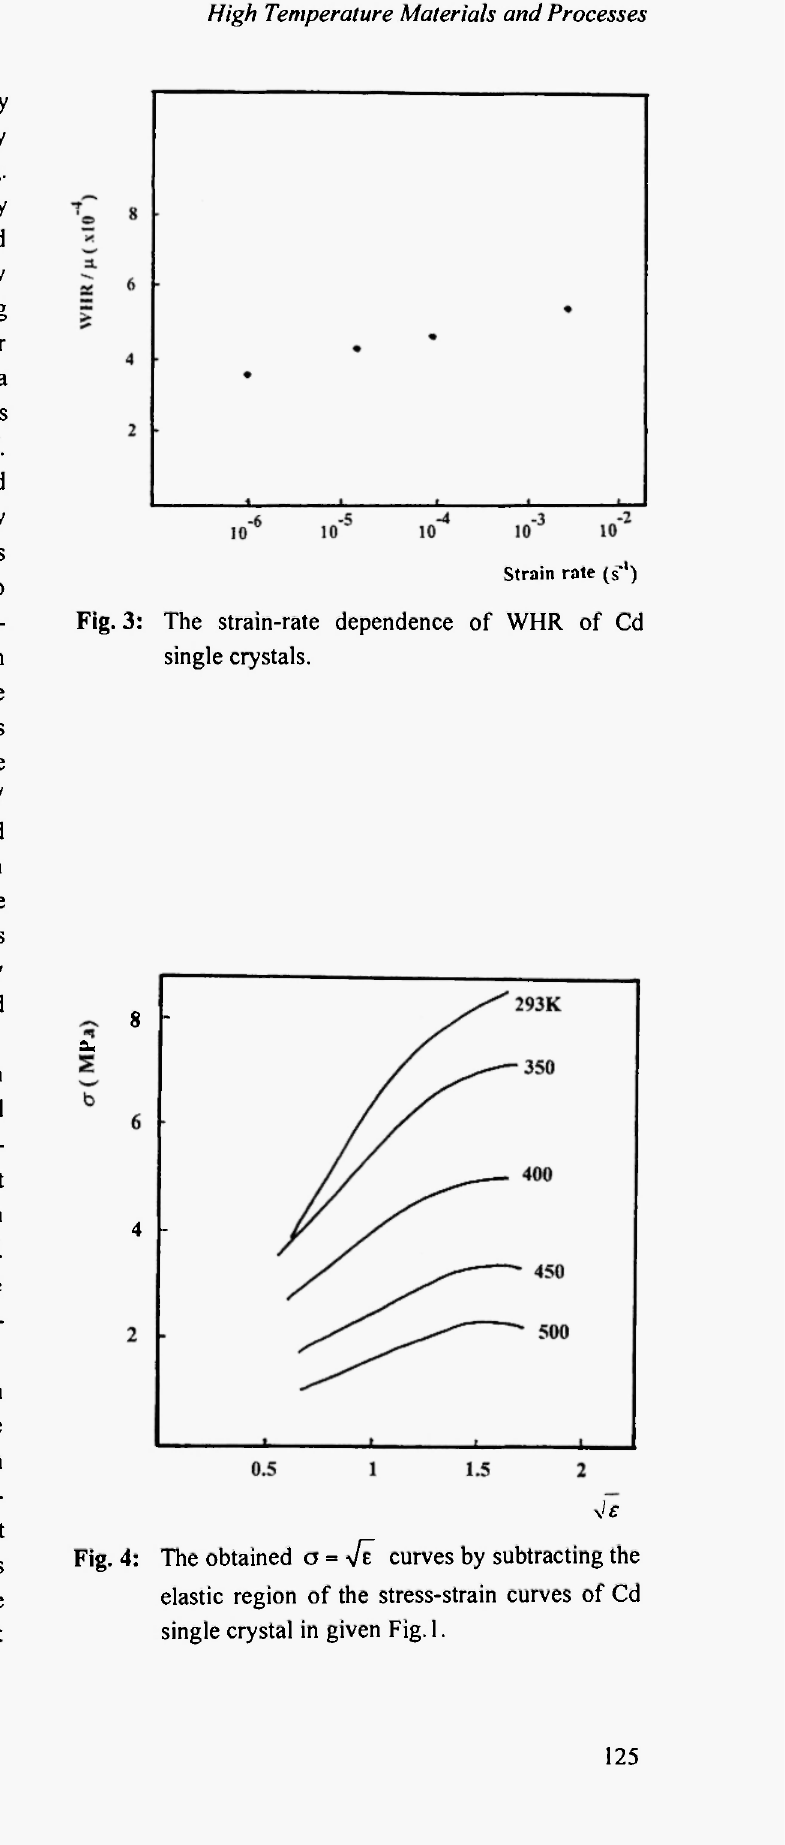
Fig. 4: The obtained σ = VT curves by subtracting the elastic region of the stress-strain curves of Cd single crystal in given